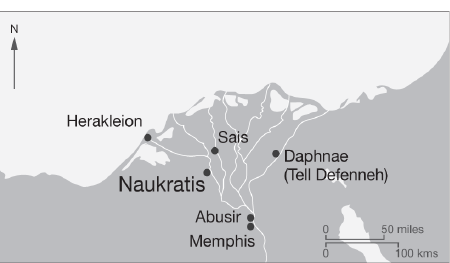
Fig. 1: Map of the Nile Delta, with relevant sites. Courtesy of the Trustees of the British